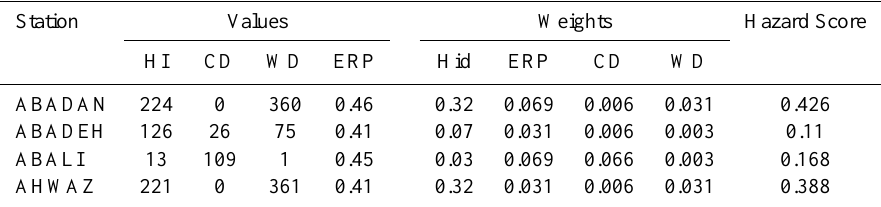
Table 5. An example of weighting of each station. Station Values Weights